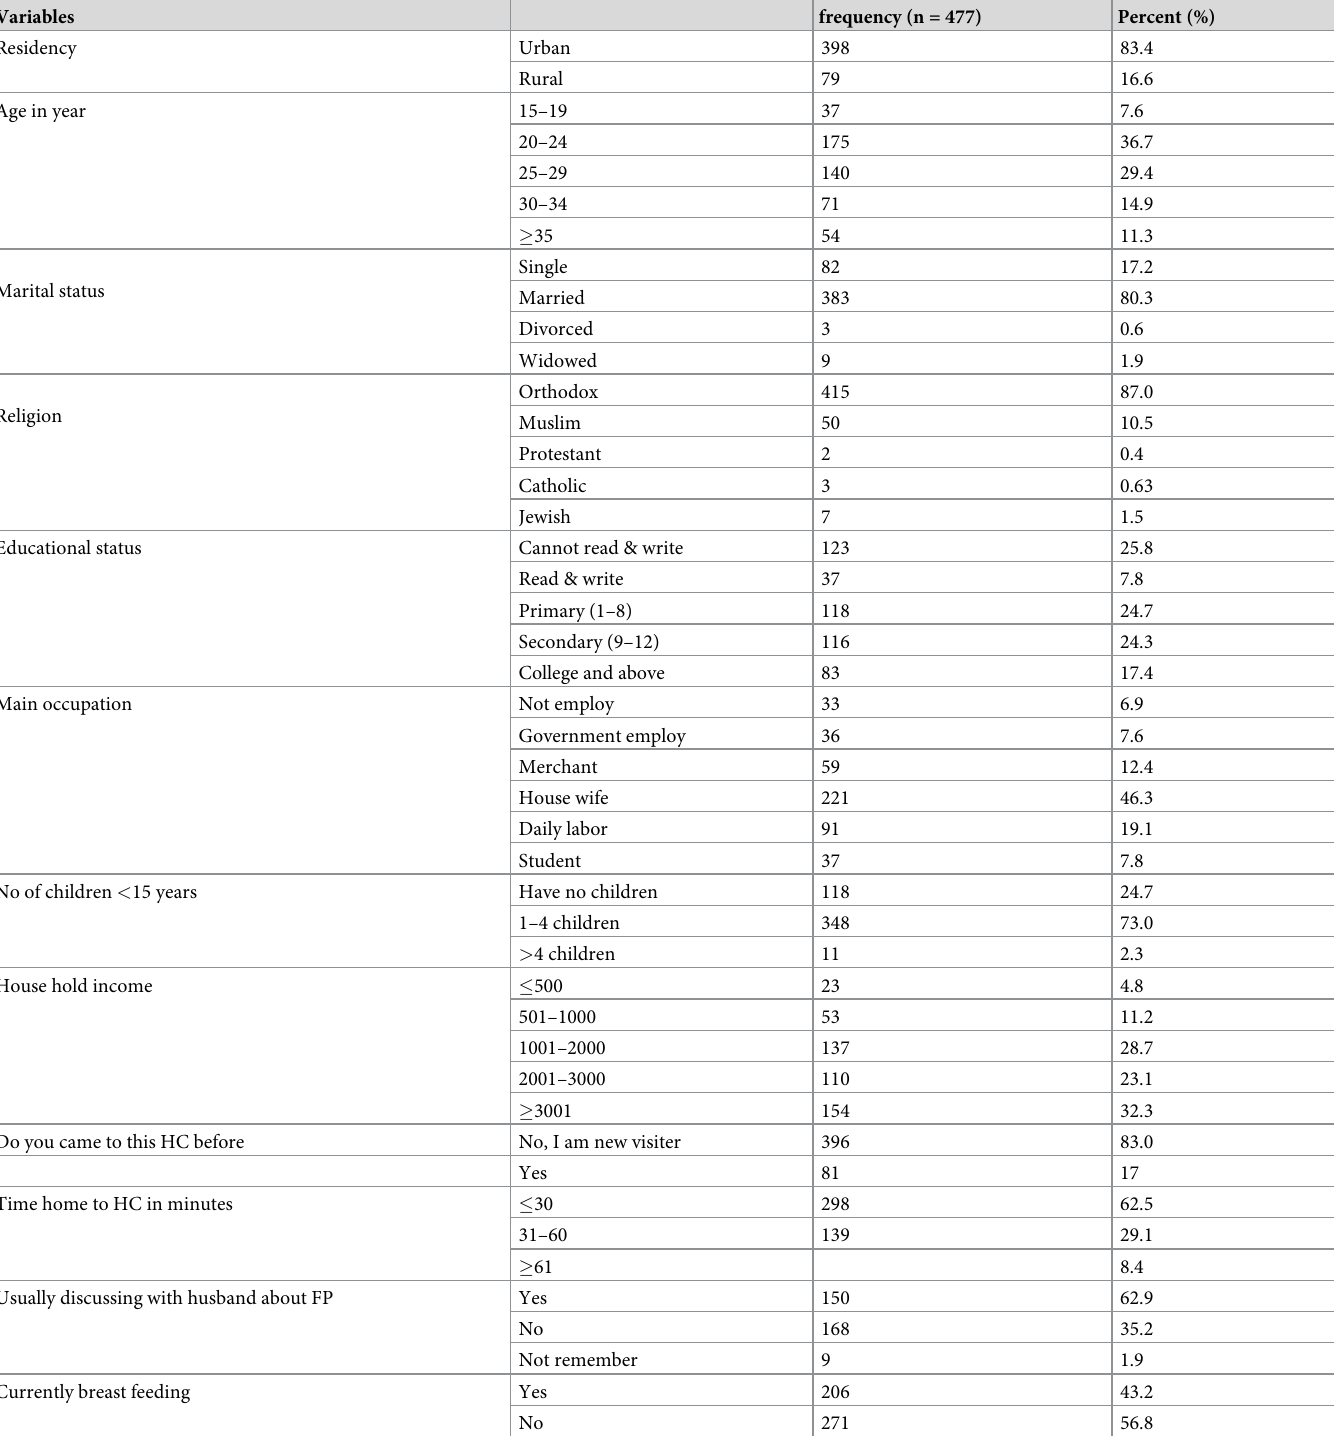
Table 4. Socio-demographic characteristics of family planning service clients in Gondar city public health facilities, Northwest of Ethiopia,